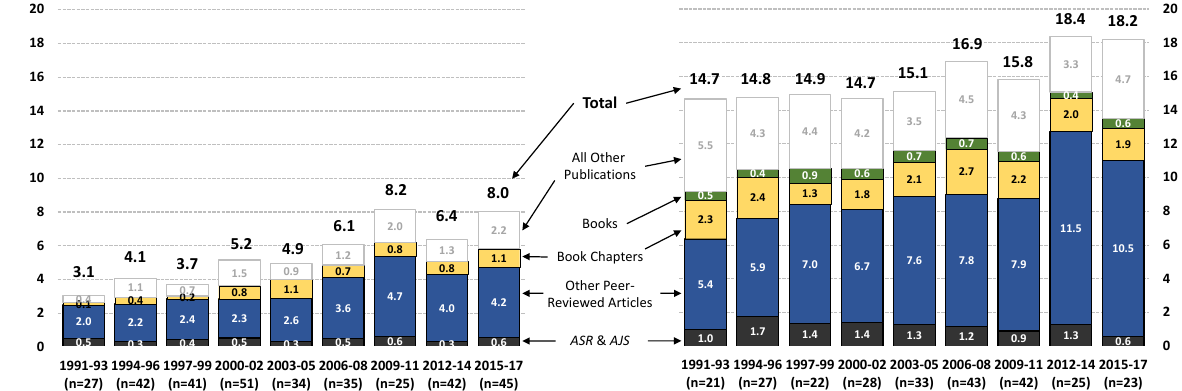
Figure 3: Mean number of publications by type and year. Shown are new assistant professors (left) and newly promoted associate professors (right).